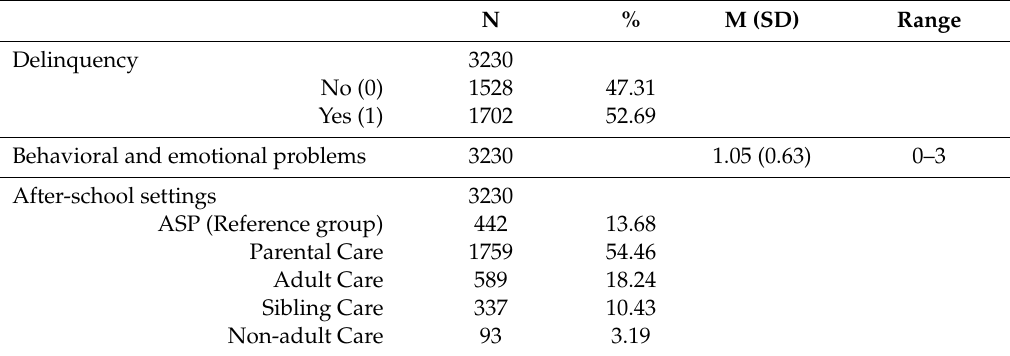
Table 1. Percentages, mean, and standard deviation of the